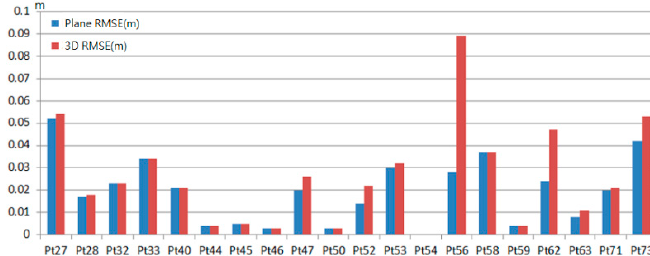
Figure 21. Plane and 3D RMSE of the check points.